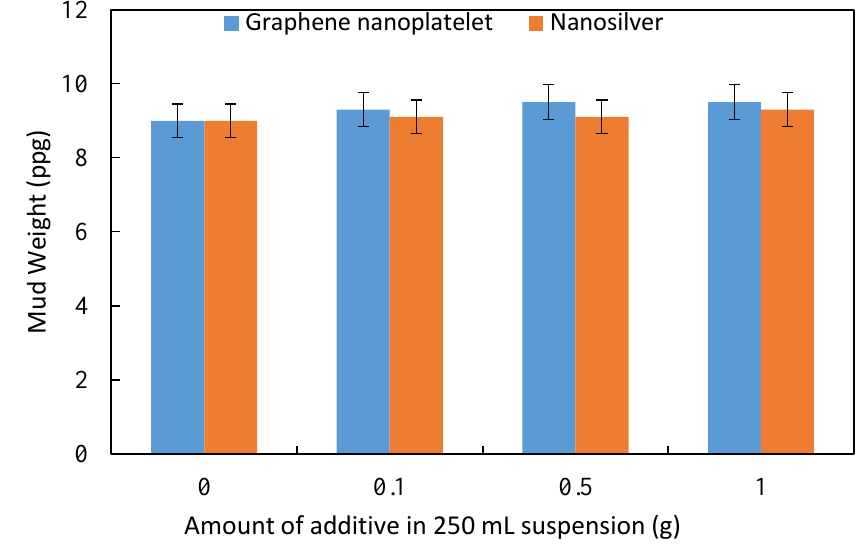
Figure 3. Density measurement of water-based muds with 5% error bar.